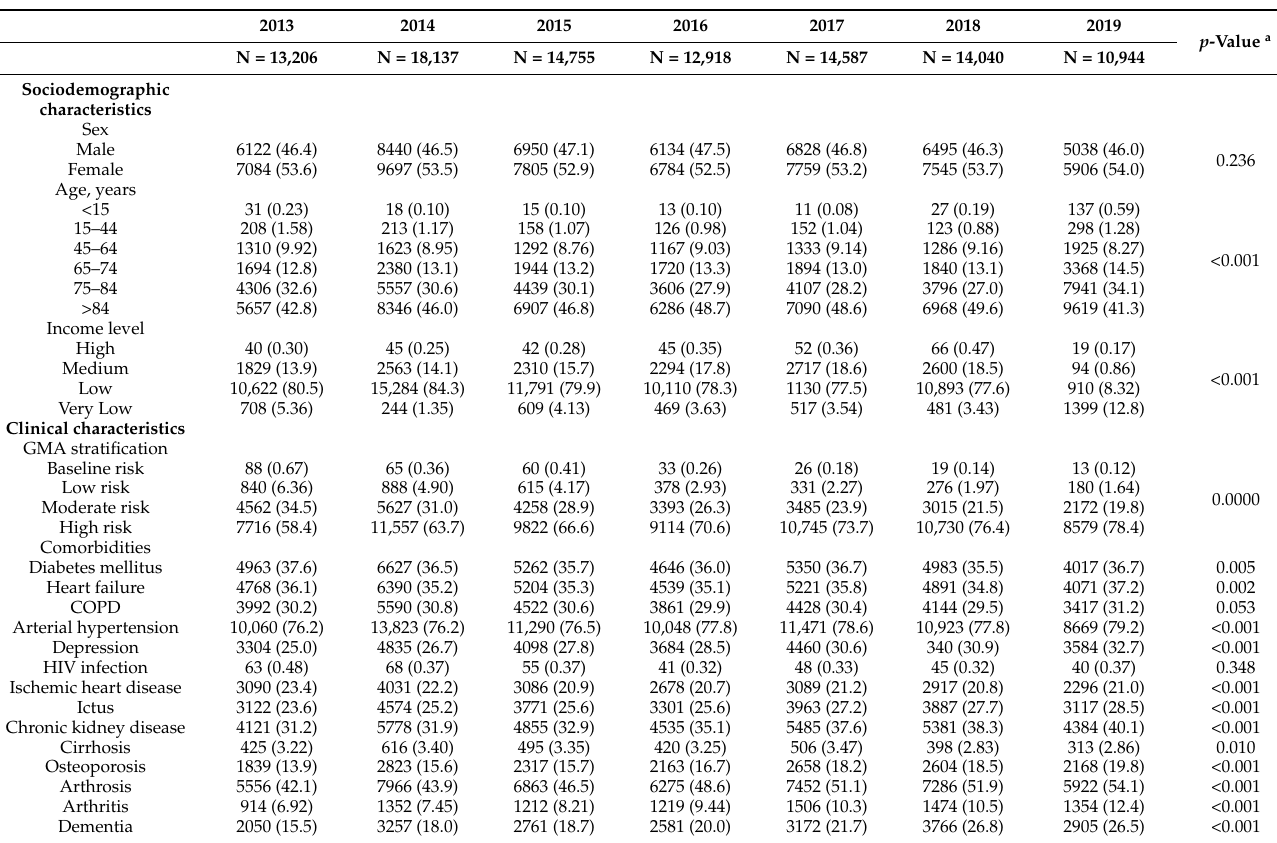
Table 3. Evolution of the sociodemographic and clinical characteristics of advanced chronic patients throughout the study period, n